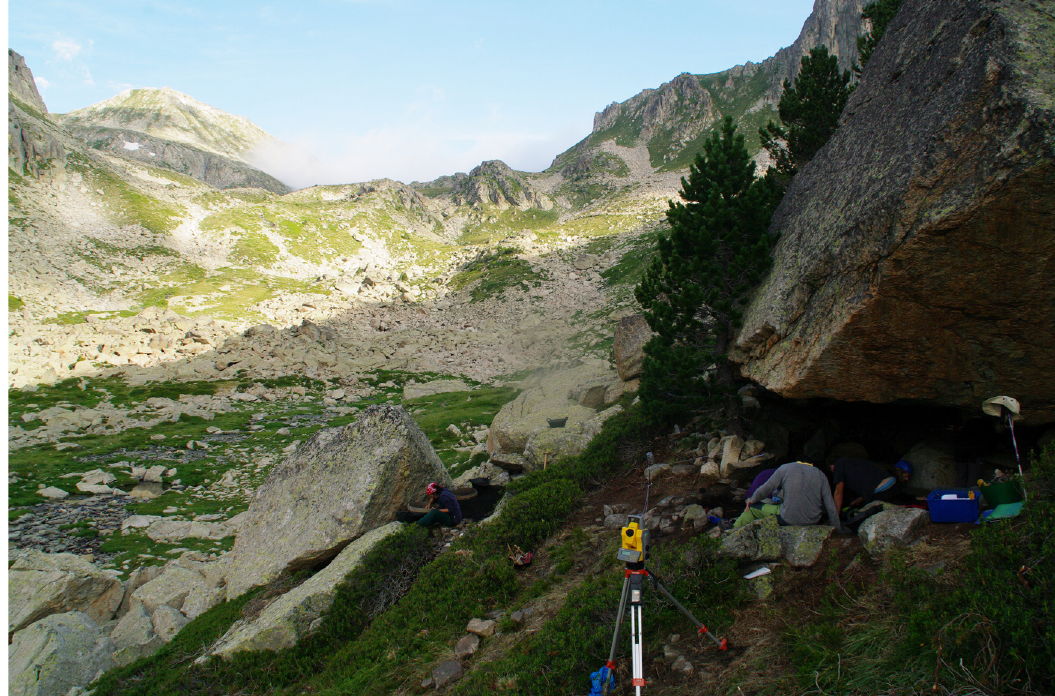
Figure 2: General view of Obagues de Ratera rockshelter during its excavation in